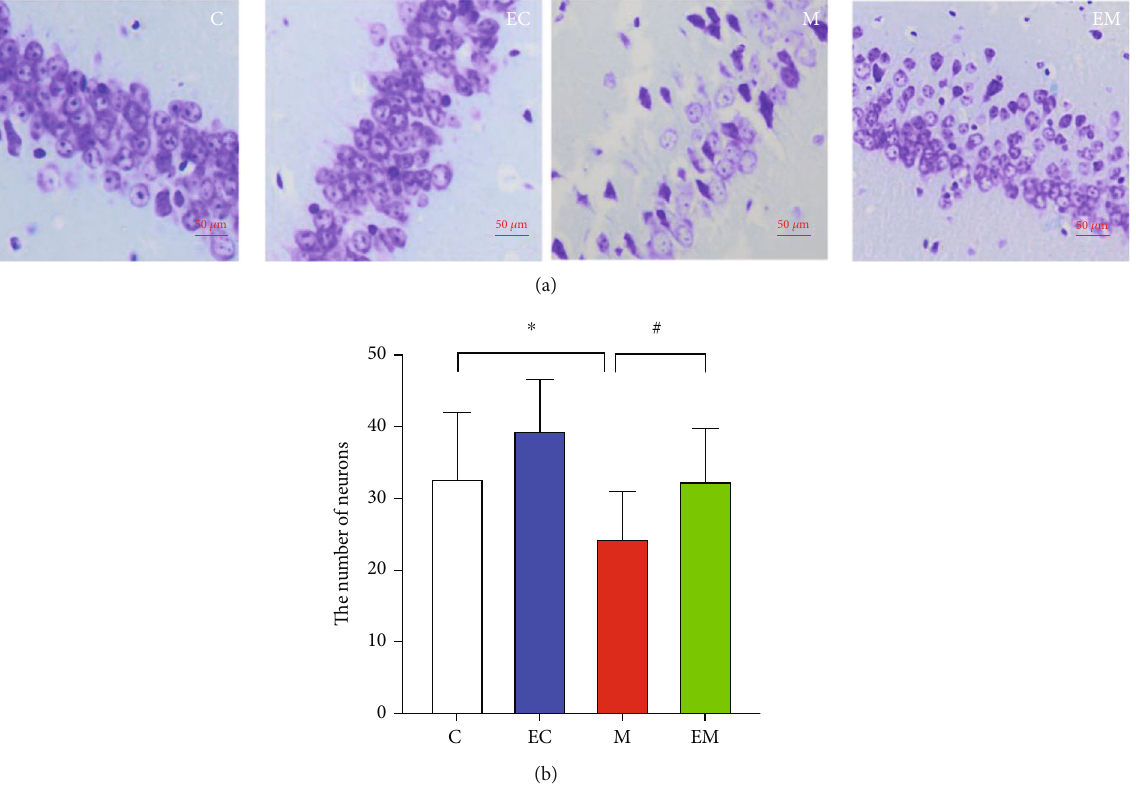
Figure 2: E ff ect of exercise on apoptosis in the hippocampus of AD mice. (a) Nissl staining of the hippocampal CA1 region. (b) The number of positive cells in the hippocampal CA1 region. Results are mean ± SD ( n = 8/group ). ∗ P < 0 : 05 and ∗∗ P < 0 : 01 vs. group C; # P < 0 : 05 and ## P < 0 : 01 vs. group M. Scale bar: 50 μ